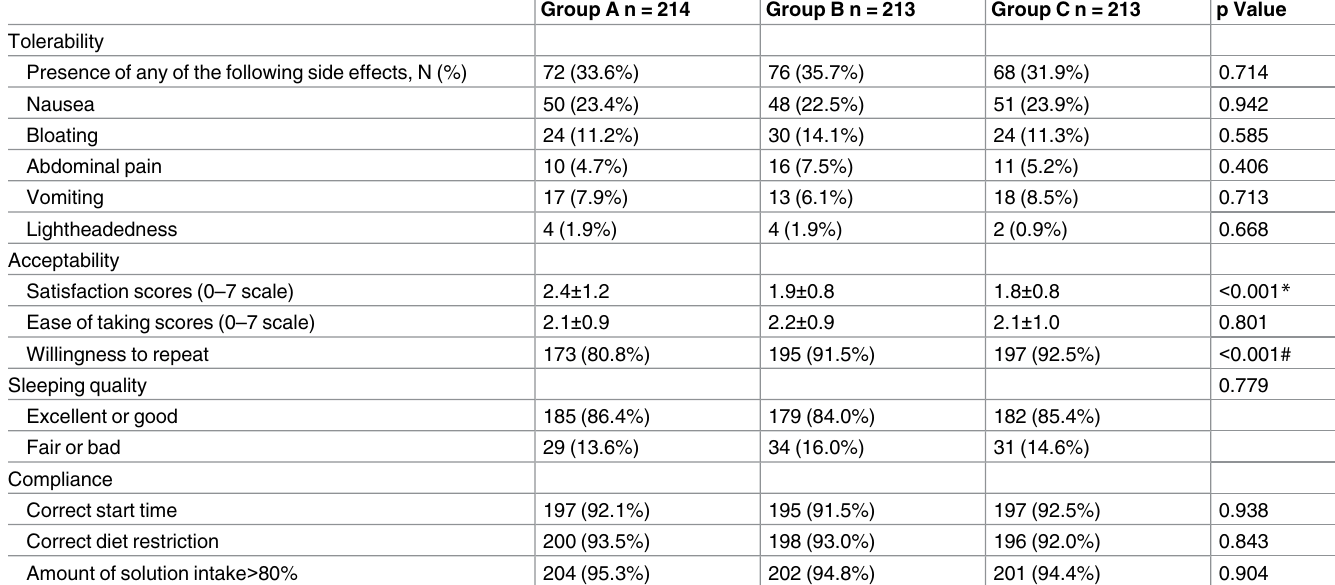
Table 4. Other secondary endpoints at per-protocol